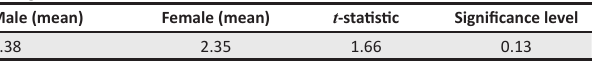
TABLE 3: Gender differences in the knowledge and understanding of climate